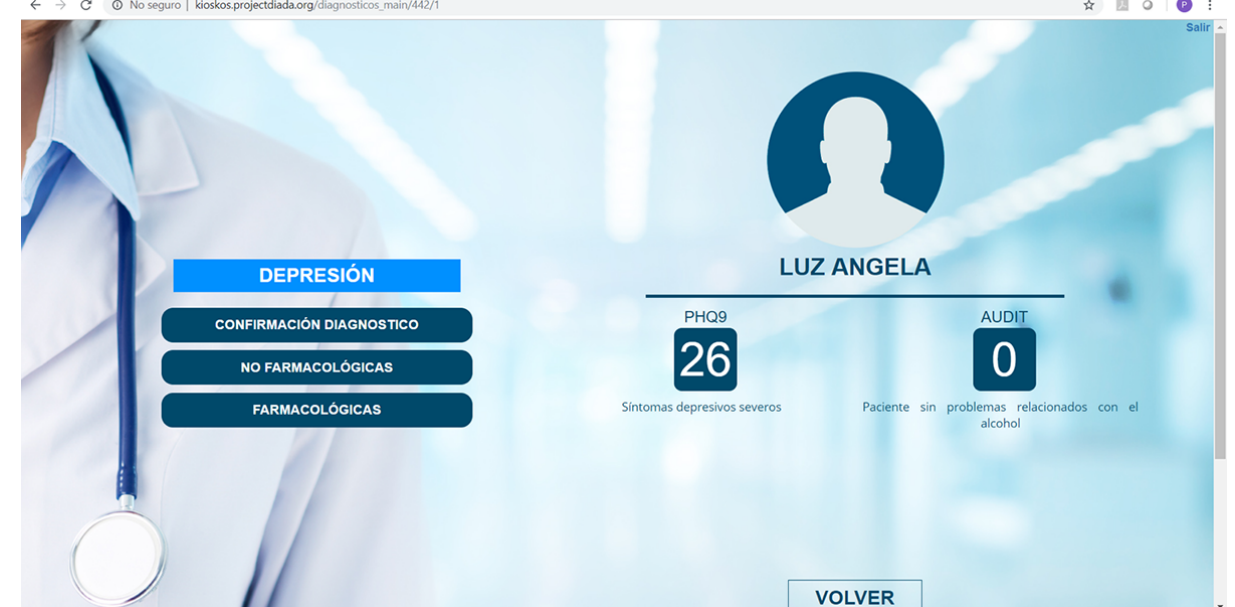
Figure 4. Decision support tool for primary care physicians displaying patient scores for depression and alcohol use disorder